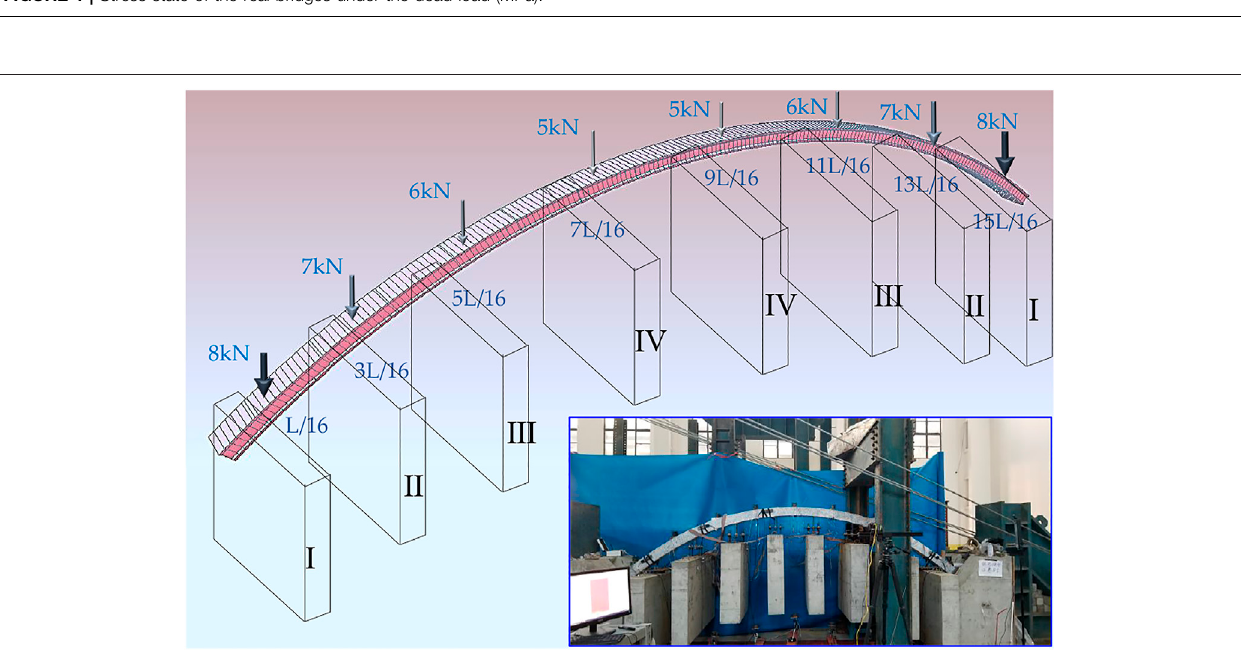
FIGURE 2 | Stress state simulation of the arch model under the dead